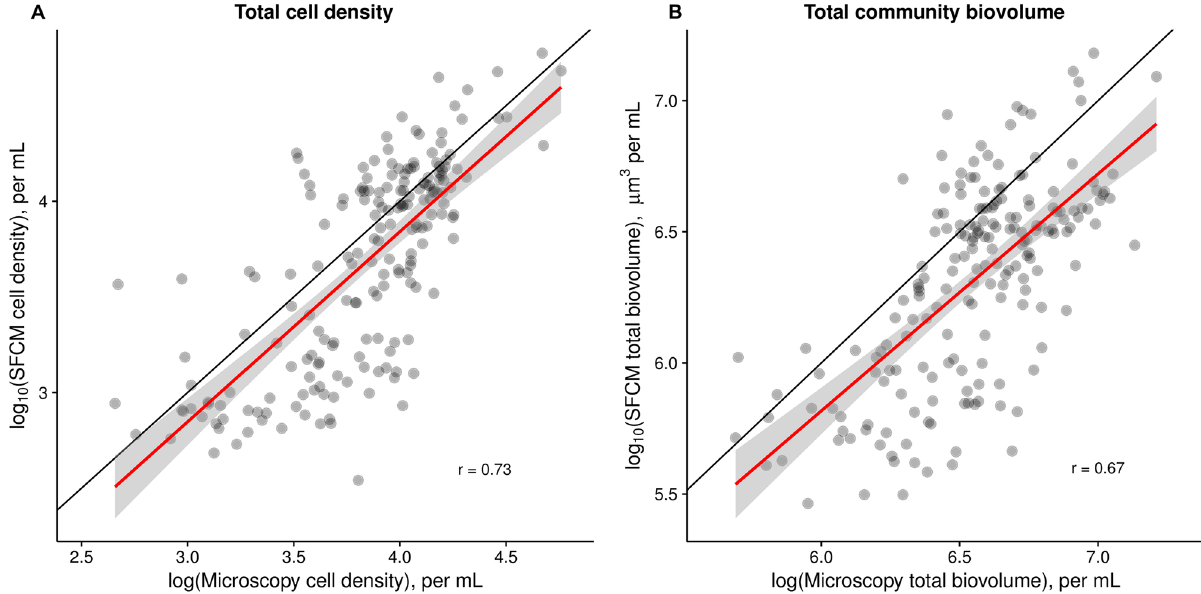
Fig 3. Whole-community cell density and biovolume estimates are quantitatively similar when measured by SFCM and microscopy. Estimates of whole-community cell density and biovolume by SFCM are strongly correlated with those by microscopy (on the log scale), and are quantitatively similar. Each point represents a single depth-specific sample measured using both methods. The black line is the 1:1 line and the red line represents the regression relationship. A) Cell density estimates are strongly correlated (r = 0.73, p < 0.001). B) Whole-community total biovolume estimates are strongly correlated (r = 0.67, p < 0.001). The slope of the regression is indistinguishable from the expected value of 1 (mean = 0.90, CIs: 0.76, 1.05) and the intercept is indistinguishable from the expected value of 0 (mean = -0.40, CIs: -0.54, 1.33).